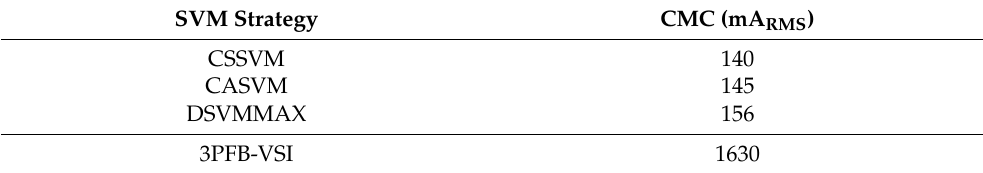
Figure 16. Experimental common mode voltage ( CMV 1 ) and common mode current (CMC) of the three-phase DCM-232 inverter under the ( a ) CSSVM, ( b ) CASVM, and ( c ) DSVMMAX techniques. Table 5. CMC magnitudes of the DCM-232 under the proposed SVPWM